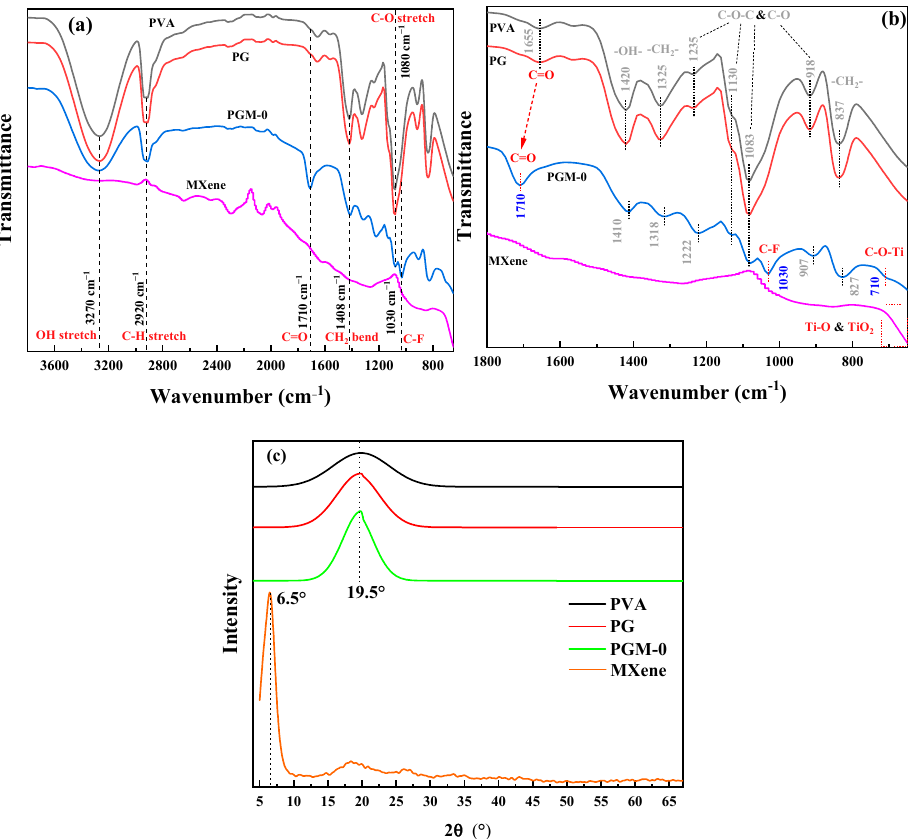
Figure 5. ( a , b ) FTIR spectra and ( c ) XRD curves of the PVA, PG, PGM-0 composite membranes and the MXene powder.